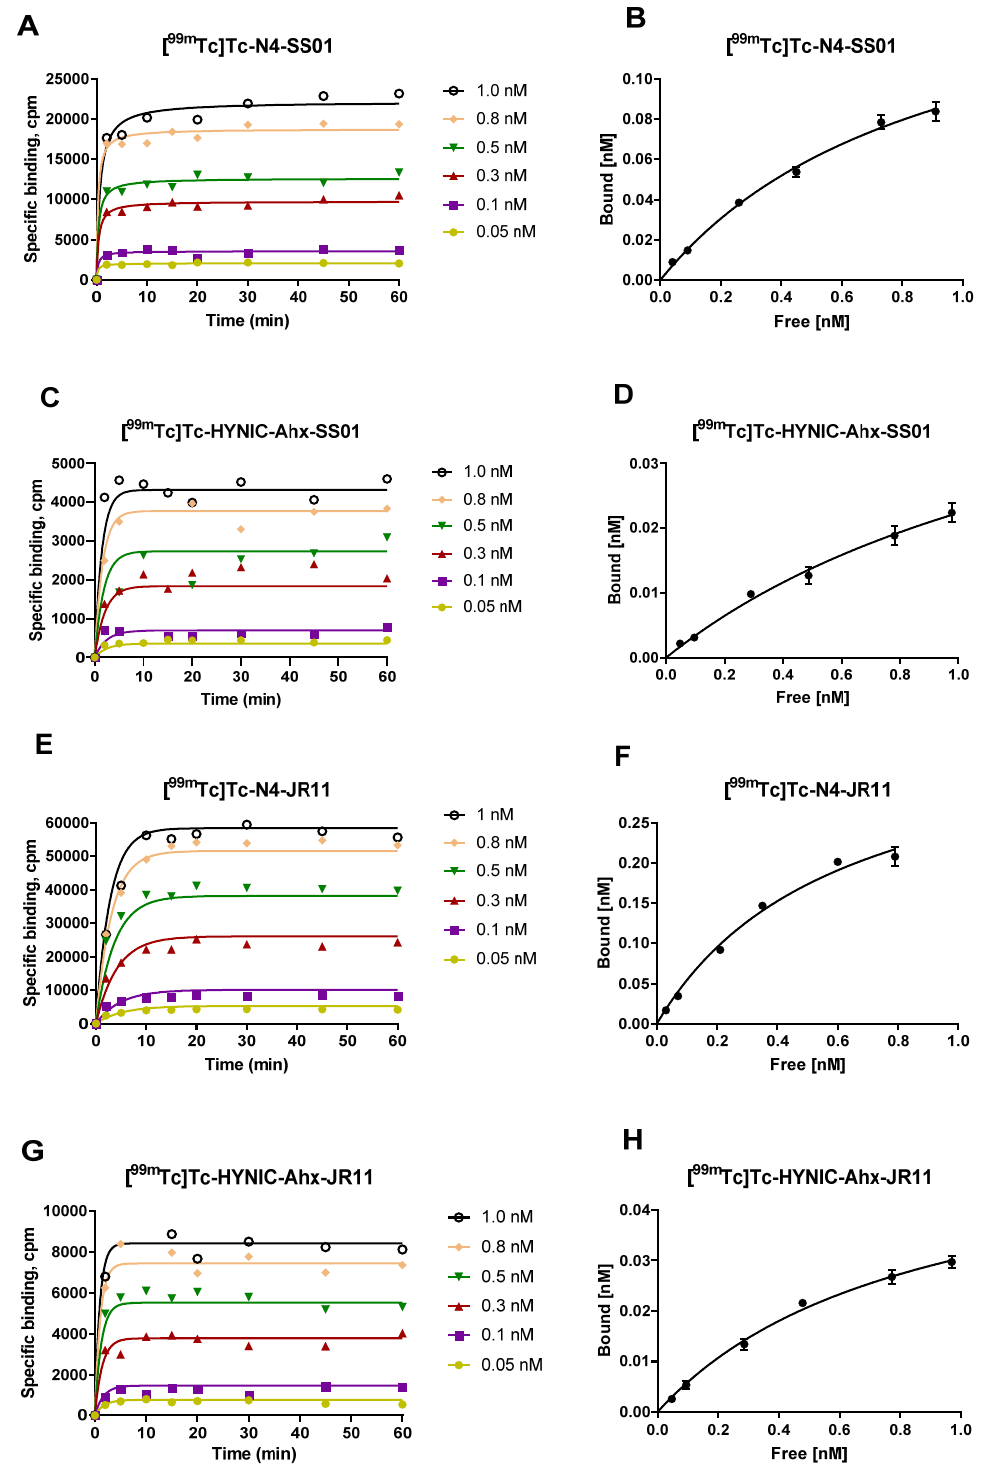
Figure 4. ( A , C , E , G ) Association profiles of the four radiotracers obtained by incubating the HEK-SST2 cell membrane (10 µ g/well) with the indicated concentrations of corresponding radiotracer over 60 min. Data were fitted using the one-phase exponential association equation. ( B , D , F , H ) Saturation binding profiles for the radioligands obtained by association data . Data were treated with the equation: one site, specific binding (GraphPad, Software Inc., Prism 7.